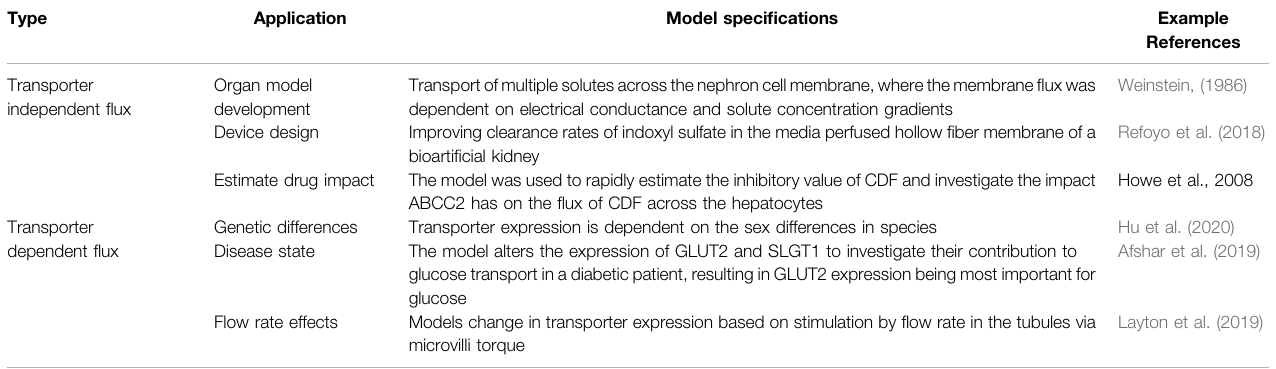
TABLE 1 | Differences in model results when using mechanistic computational models with a fl ux boundary condition dependent on transporter density or not by various